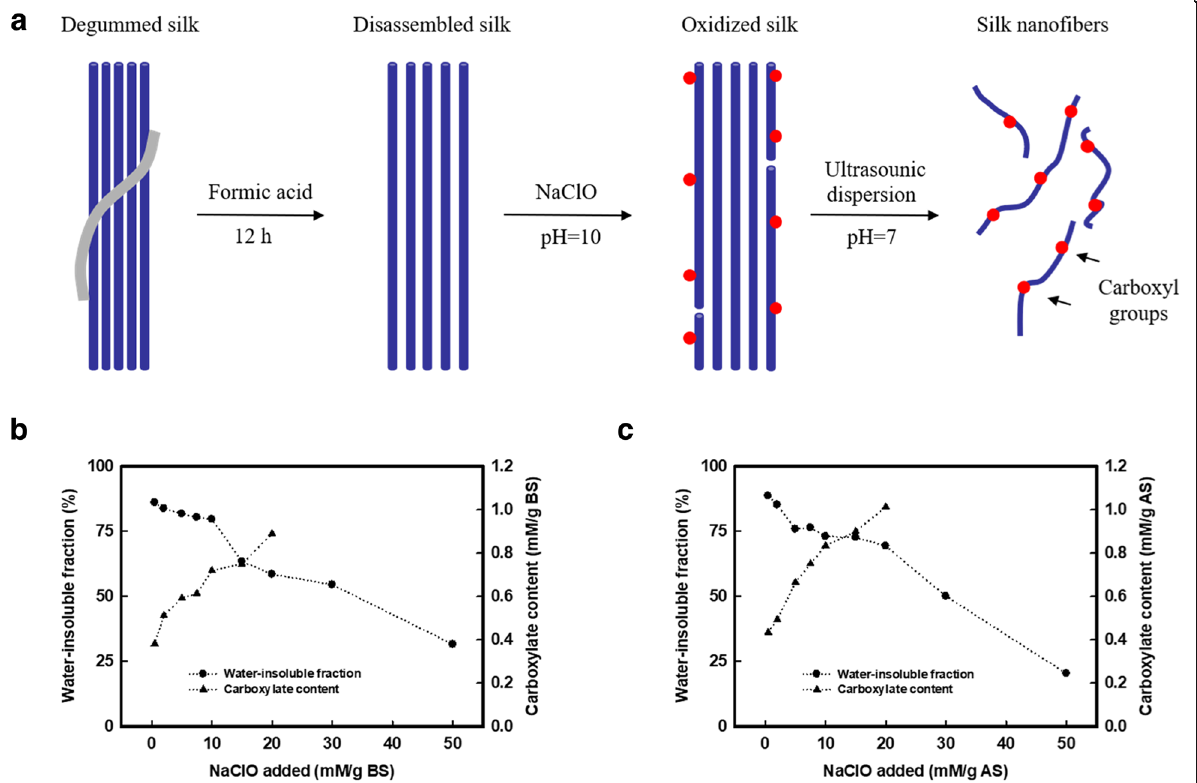
Fig. 1 Process diagram of SNs and carboxyl content of BS and AS. a Schematic of oxidation and dispersing of silk fiber to silk nanofibers (SNs). b The content of carboxyl groups and weight remaining of water-insoluble fraction after oxidation of Bombyx mori (BS) corresponding to the addition of sodium hypochlorite (NaClO). The carboxyl content increased from 0.293 to 0.889mM/g BS (NaClO addition was 20mM/g protein) with 58.52wt% of protein remaining. c For Antheraea pernyi silk (AS). The carboxyl content increased from 0.347 to 1.013mM/g AS (NaClO addition was 20mM/g protein) with 69.30wt% of protein